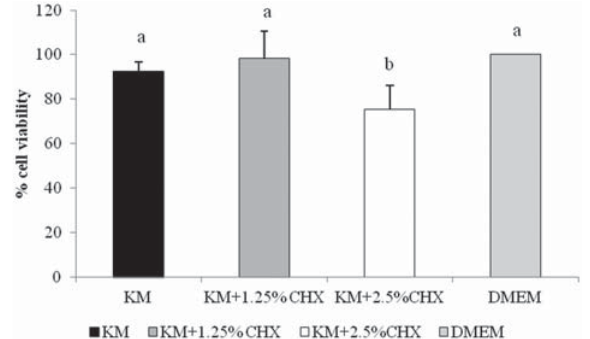
Figure 1 Box-whisker plots of the S. mutans (cid:3)(cid:68)(cid:81)(cid:87)(cid:76)(cid:16)(cid:69)(cid:76)(cid:82)(cid:191)(cid:79)(cid:80)(cid:3)(cid:68)(cid:70)(cid:87)(cid:76)(cid:89)(cid:76)(cid:87)(cid:92)(cid:3) of the glass ionomer cements. Bars indicate minimum and maximum values. Black and white boxes indicate lower and (cid:88)(cid:83)(cid:83)(cid:72)(cid:85)(cid:3)(cid:84)(cid:88)(cid:68)(cid:85)(cid:87)(cid:76)(cid:79)(cid:72)(cid:86)(cid:15)(cid:3)(cid:85)(cid:72)(cid:86)(cid:83)(cid:72)(cid:70)(cid:87)(cid:76)(cid:89)(cid:72)(cid:79)(cid:92)(cid:17)(cid:3)(cid:55)(cid:75)(cid:72)(cid:3)(cid:79)(cid:76)(cid:81)(cid:72)(cid:3)(cid:76)(cid:81)(cid:3)(cid:87)(cid:75)(cid:72)(cid:3)(cid:80)(cid:76)(cid:71)(cid:71)(cid:79)(cid:72)(cid:3)(cid:82)(cid:73)(cid:3)(cid:87)(cid:75)(cid:72)(cid:3)(cid:69)(cid:82)(cid:91)(cid:72)(cid:86)(cid:3) is the median Table 2- (cid:3)(cid:48)(cid:72)(cid:70)(cid:75)(cid:68)(cid:81)(cid:76)(cid:70)(cid:68)(cid:79)(cid:3)(cid:83)(cid:85)(cid:82)(cid:83)(cid:72)(cid:85)(cid:87)(cid:76)(cid:72)(cid:86)(cid:3)(cid:11)(cid:80)(cid:72)(cid:68)(cid:81)(cid:86)(cid:3)(cid:147)(cid:3)(cid:86)(cid:87)(cid:68)(cid:81)(cid:71)(cid:68)(cid:85)(cid:71)(cid:3)(cid:71)(cid:72)(cid:89)(cid:76)(cid:68)(cid:87)(cid:76)(cid:82)(cid:81)(cid:86)(cid:12)(cid:3)(cid:82)(cid:73)(cid:3)(cid:74)(cid:79)(cid:68)(cid:86)(cid:86)(cid:3)(cid:76)(cid:82)(cid:81)(cid:82)(cid:80)(cid:72)(cid:85)(cid:3)(cid:70)(cid:72)(cid:80)(cid:72)(cid:81)(cid:87)(cid:86)(cid:3)(cid:70)(cid:82)(cid:81)(cid:87)(cid:68)(cid:76)(cid:81)(cid:76)(cid:81)(cid:74)(cid:3)(cid:82)(cid:85)(cid:3)(cid:81)(cid:82)(cid:87)(cid:3)(cid:70)(cid:75)(cid:79)(cid:82)(cid:85)(cid:75)(cid:72)(cid:91)(cid:76)(cid:71)(cid:76)(cid:81)(cid:72)